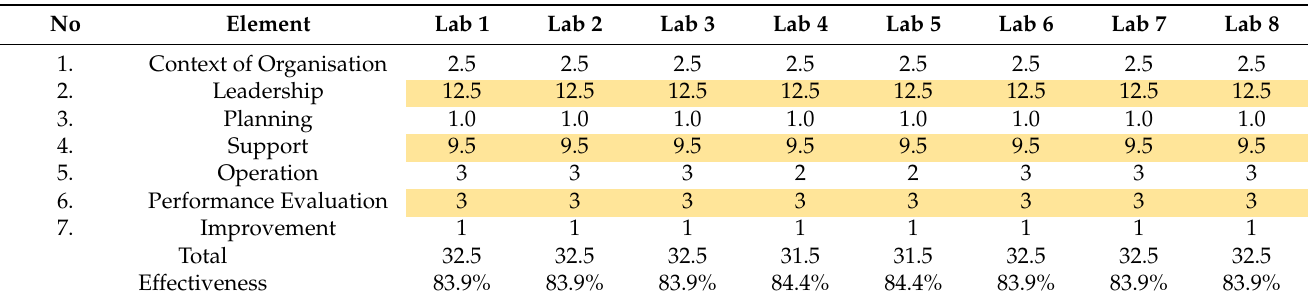
Table 4. Gap analysis of each